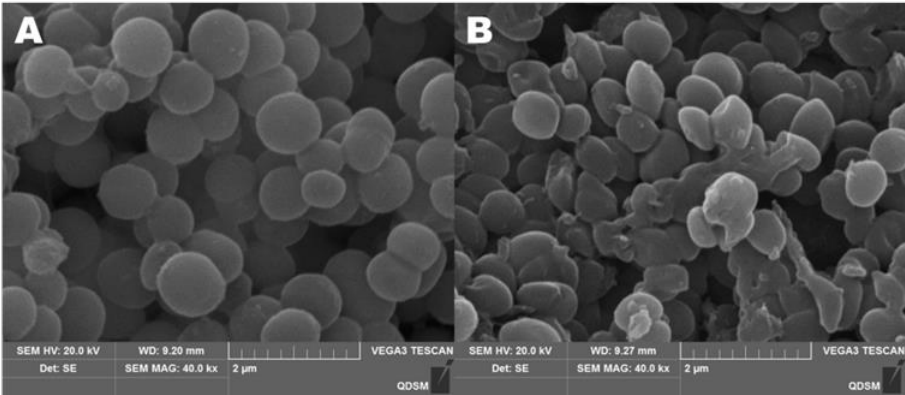
Figure 8. SEM images of S. aureus untreated ( A ) and treated ( B ) with cinnamaldehyde for 4 h.